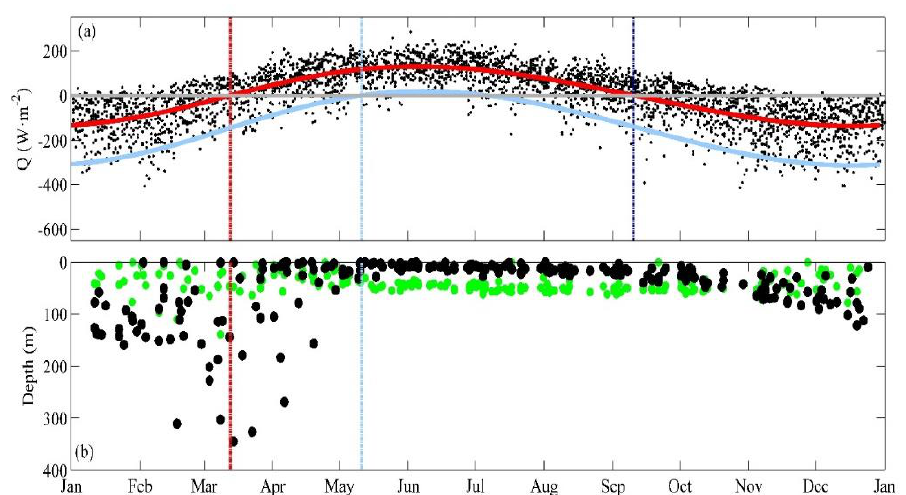
Figure 6. Surface chlorophyll concentration from daily (green line) and weekly (blue cross line) satellite-derived Chlorophyll a concentration from GlobColour project and net heat flux (Q 0 ) (black line) from the ocean to the atmosphere (negative values imply a heat loss by the ocean) at different locations in the mid-latitudes of the Eastern North Atlantic. ( a ) at the grid centered at 44.76° N, 15° W from NCEP/NCAR reanalysis data. Chlorophyll time-series are obtained as the average daily and weekly time-series within this grid 44.76°N ± 1.9 /2° N and 15° W ± 1.9/2° E (NCEP/NCAR spatial resolution is 1.9° × 1.9°). ( b ), ( c ), and ( d ) idem at the grids at 46.67° N, 5.62° W; 44.76° N, 9.38° W; and 42.86° N, 11.25° W. Chlorophyll concentration scale is shown in the left y-axis in mgr·m −3 and Q 0 in the right y-axis in W·m −2 .